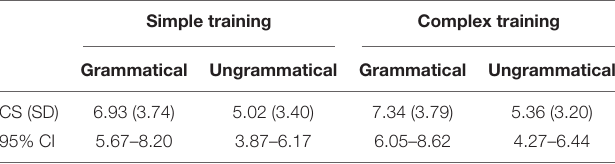
TABLE 6 | Average chunk strength of test items for each training group.